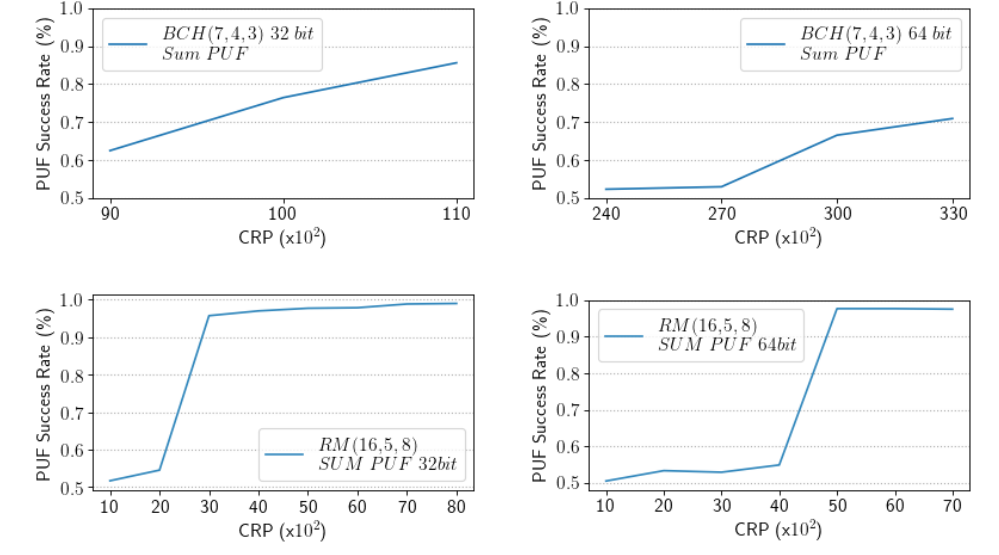
Figure 9: PUF success rate of attacks on a 32-SUM PUF and a 64-SUM PUF while utilizing XOR-equations with κ = 4 of the RM(16 , 5 , 8) code and the BCH(7 , 4 , 3) code. relate the SNN in this work to other machine learning approaches in the PUF